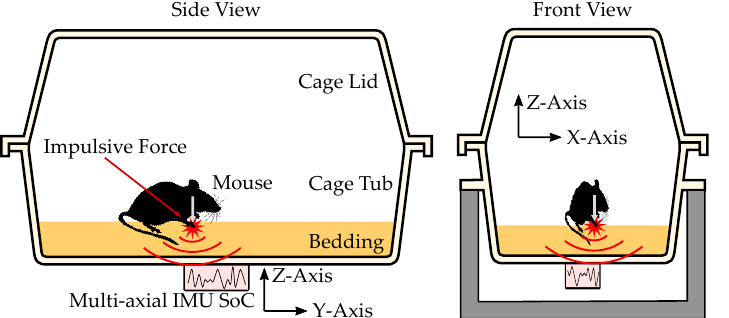
Figure 1. This drawing visually depicts the concept of the proposed method for activity detec- tion and classification based on measurements of structural vibrations with an multi-axial inertial measurement